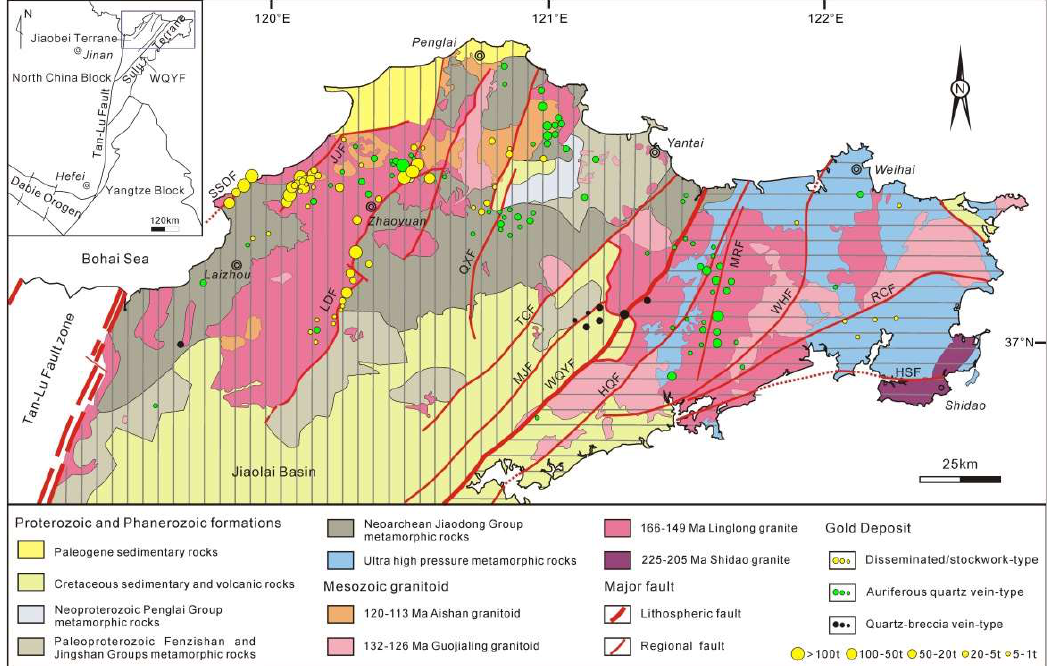
Figure 1. Simplified geological map of the Jiaodong gold province [13]. SSDF—Sanshandao fault; JJF—Jiaojia fault; LDF—Zhaoping fault; QXF—Qixia fault; TCF—Taocun fault;